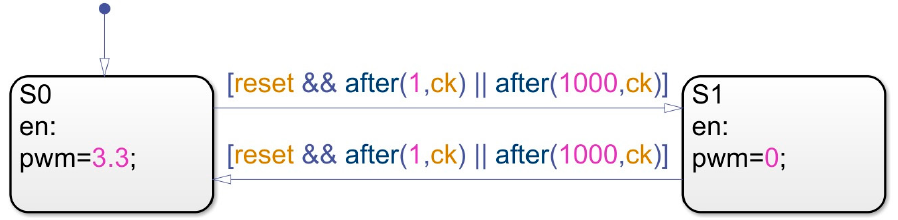
Figure 7. FSM generating the output PWM signal in the FPGA subsystem.